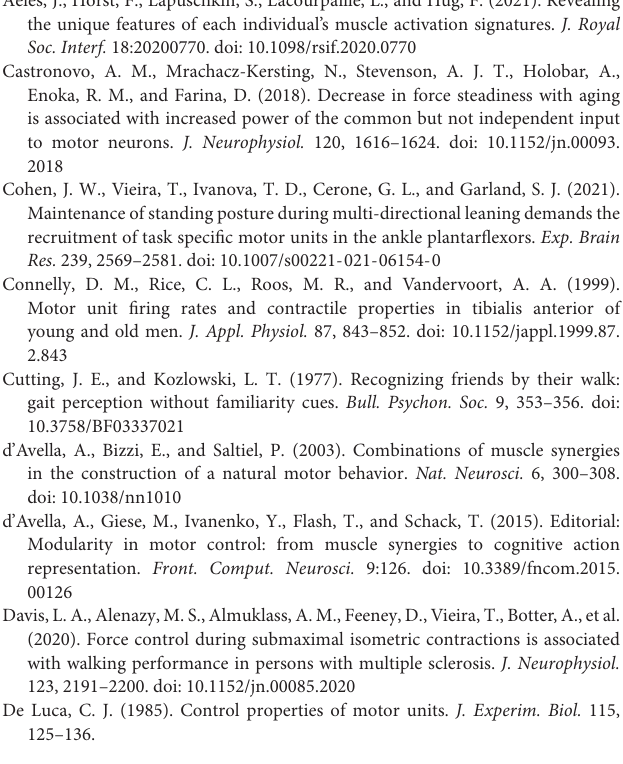
muscle sensors: combining convolutive blind source separation methods and